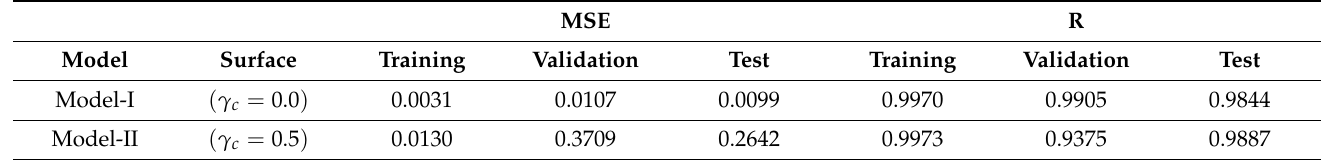
Table 11. Performance grades for constructed ANN models.